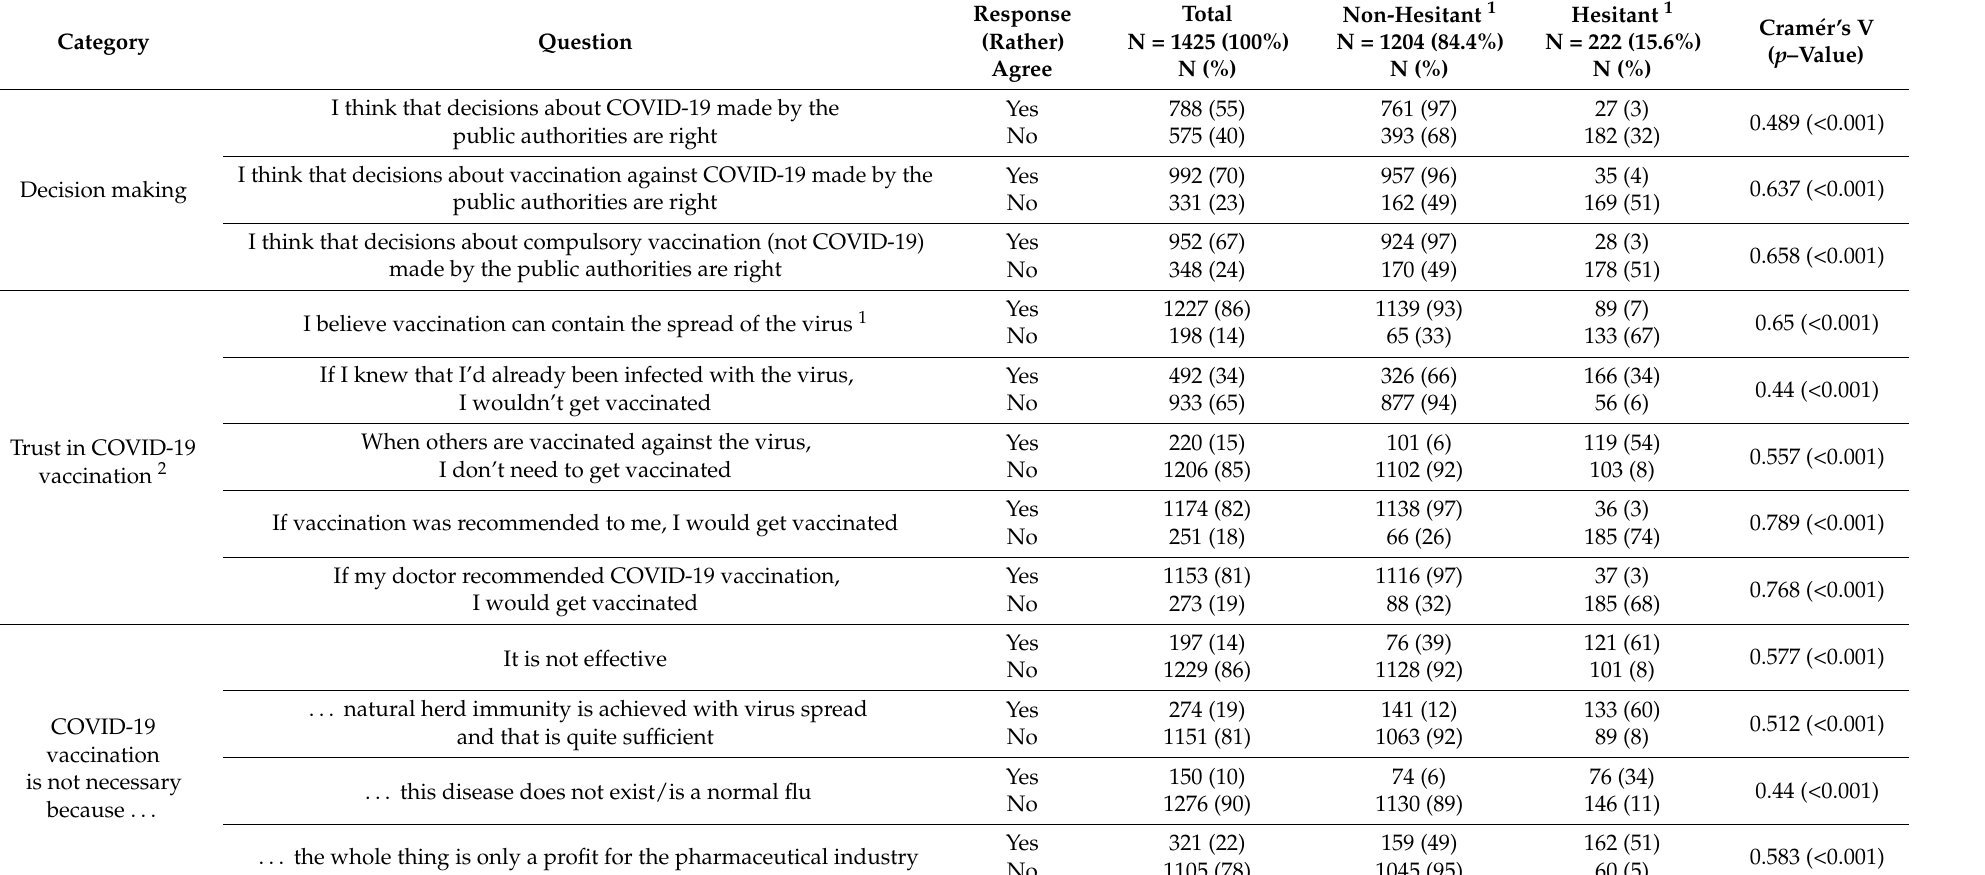
Table 2. Attitudes towards COVID-19 disease, vaccines, and vaccination of vaccination non-hesitant vs. hesitant survey